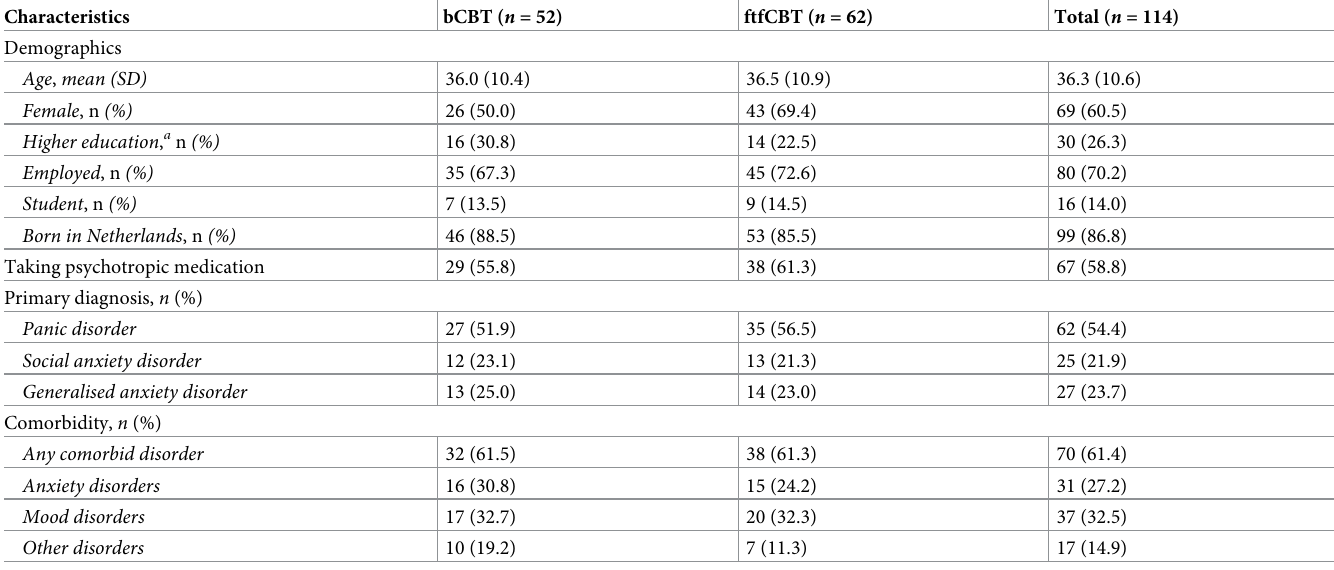
Table 1. Baseline characteristics of participants in bCBT and ftfCBT